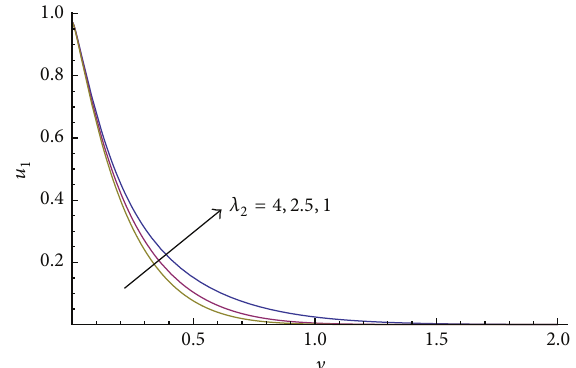
Figure 6: The variation of velocity profile 𝑢 2 (𝑥, 𝑦,𝑡) with 𝑧 for different time 𝑡 in which 𝜔 = 5 , 𝛼 = 1.5 , 𝛽 = 0.5 , 𝜆 1 = 8 , 𝜆 2 = 2 , = 1 , Re = 1 , and 𝑦 = 0.5 𝜆 3